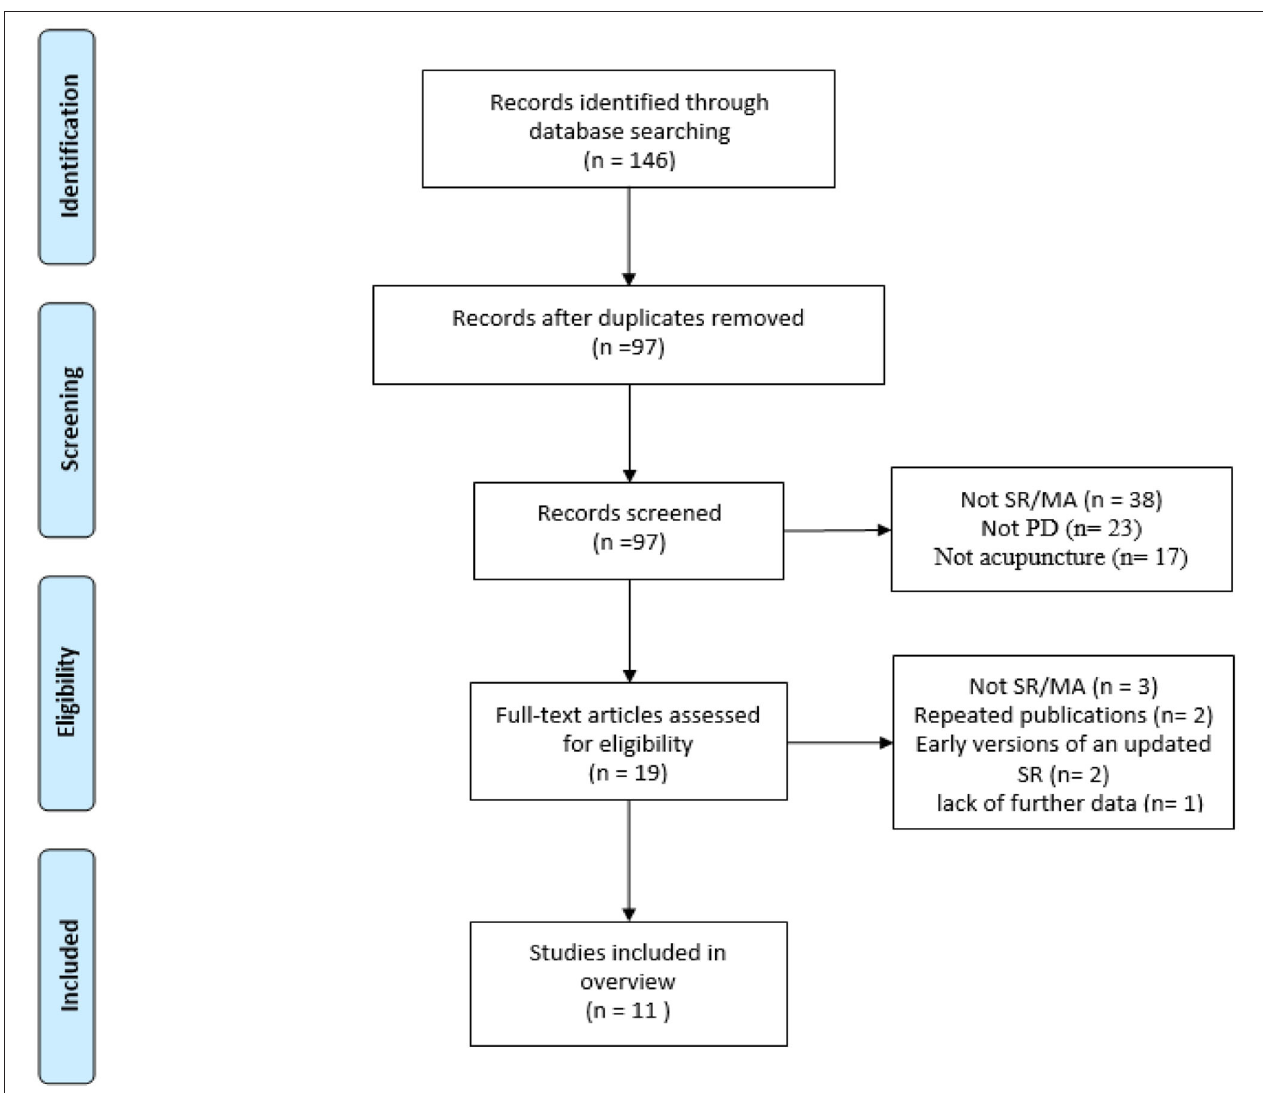
FIGURE 1 | Flowchart of study